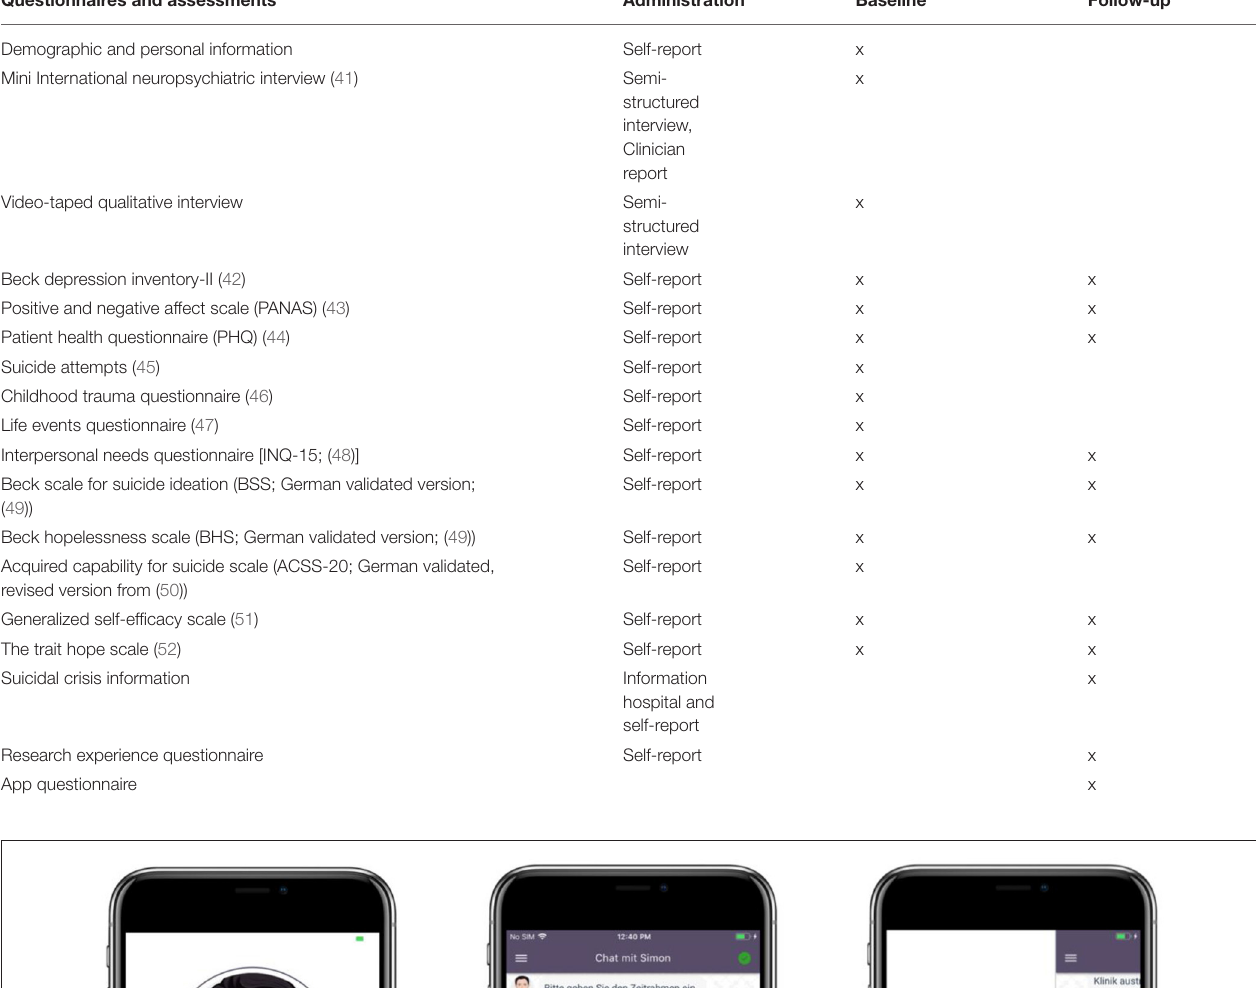
TABLE 1 | Questionnaires and assessments conducted at baseline and/or follow-up. Questionnaires and assessments